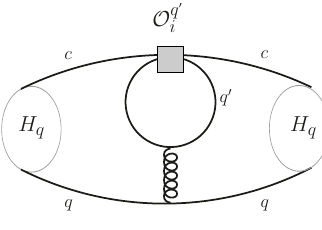
Figure 4. Diagrammatic representation of “eye contractions”, which serve as a further contribution relevant in the four-quark operators [39, 82, 83]. In particular, the quark running in the loop q 0 need not match the valence quark in the hadron, q , leading to further non-valence contributions to the decay widths. Such contributions are numerically small [39, 83], but allow, for example, for a PI contribution to the D 0